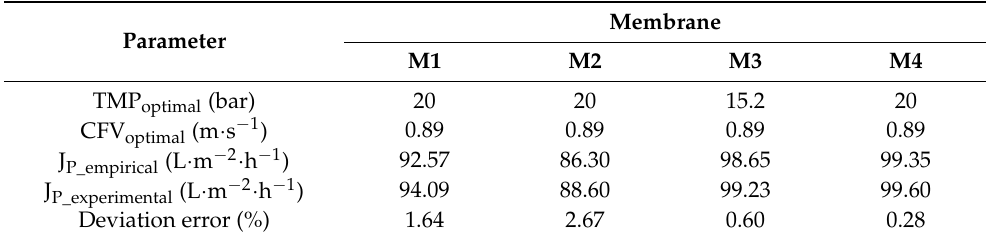
Table 7. Optimal parameters for maximising R Salt according to Statgraphics. Comparison between empirical and experimental values.